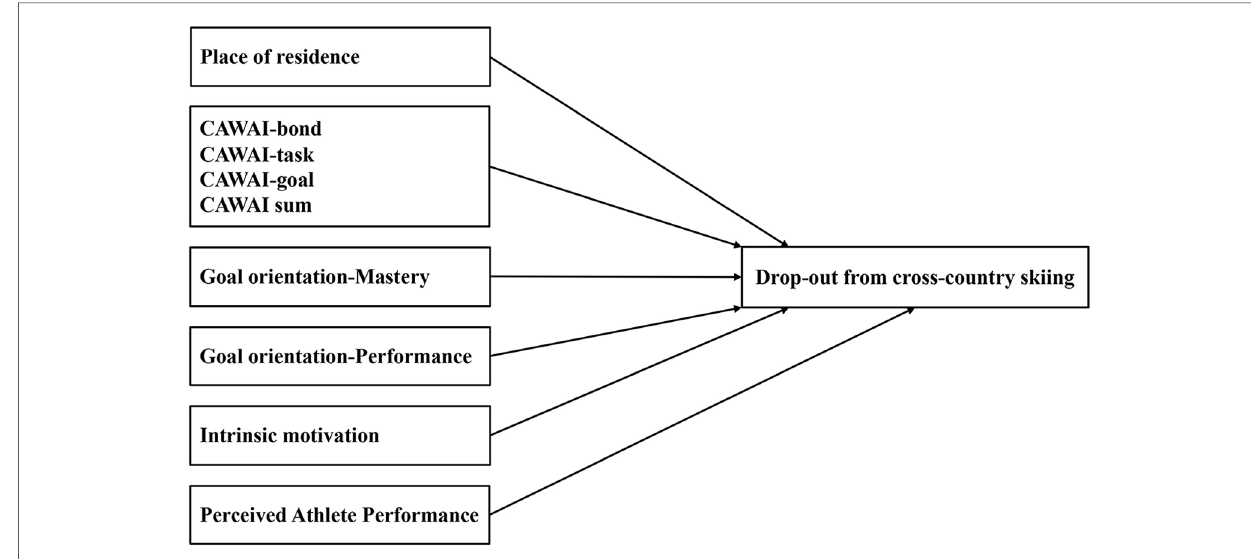
FIGURE 1 The variables in the study possible association to drop-out in cross-country